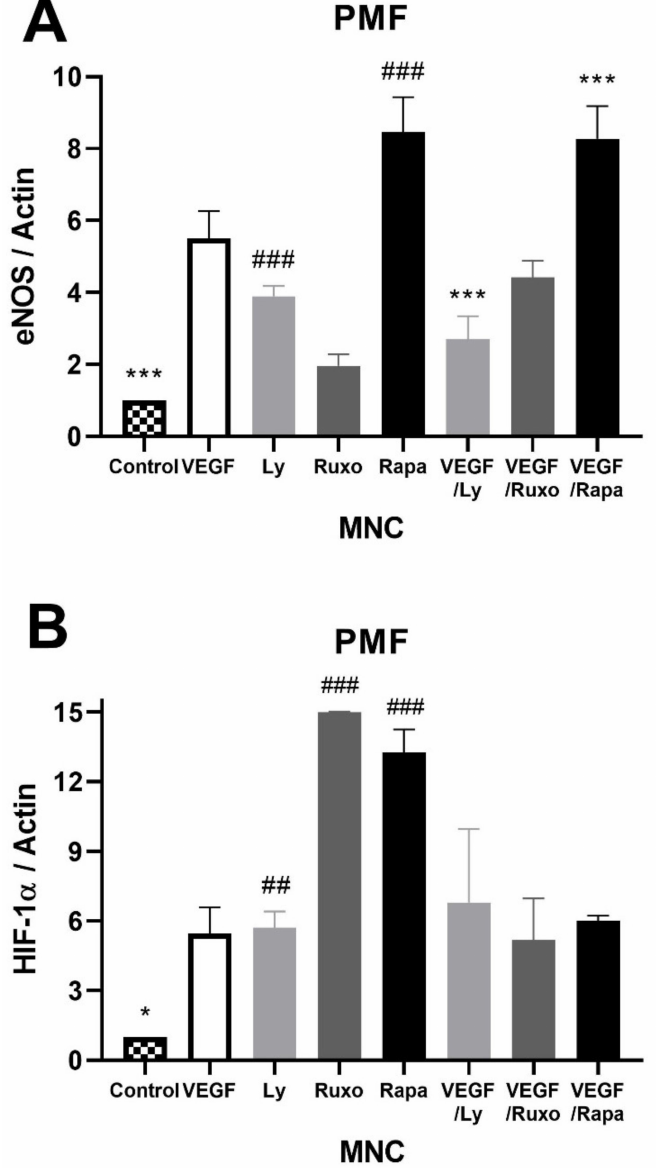
Figure 3. Vascular endothelial growth factor (VEGF) induction of angiogenic factors gene expression in primary myelofibrosis (PMF). Real time qPCR determination of endothelial nitric oxide synthase (eNOS) and hypoxia inducible factor 1- α (HIF-1 α ) presented as a ratio to Actin. The mononuclear cells (MNC) were treated for 1 h with 10 µ g/mL VEGF with or without 1 µ M JAK1/2 inhibitor Ruxolitinib, 5 µ M PI3K inhibitor LY294002 and 100 ng/mL mTOR inhibitor Rapamycin and levels of ( A ) eNOS, and ( B ) HIF-1 α were determined. Values are mean ± SEM ( n = 3). * p < 0.05, *** p < 0.001 vs. VEGF treated cells. ## p < 0.01, ### p < 0.001 vs.